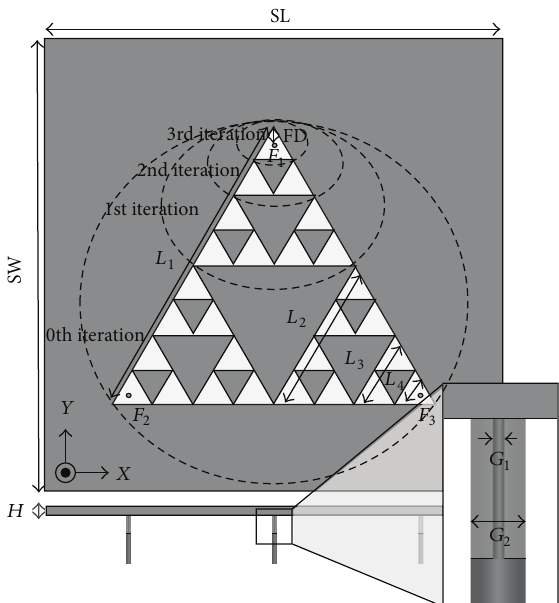
Figure 1: Configuration of the proposed antenna.